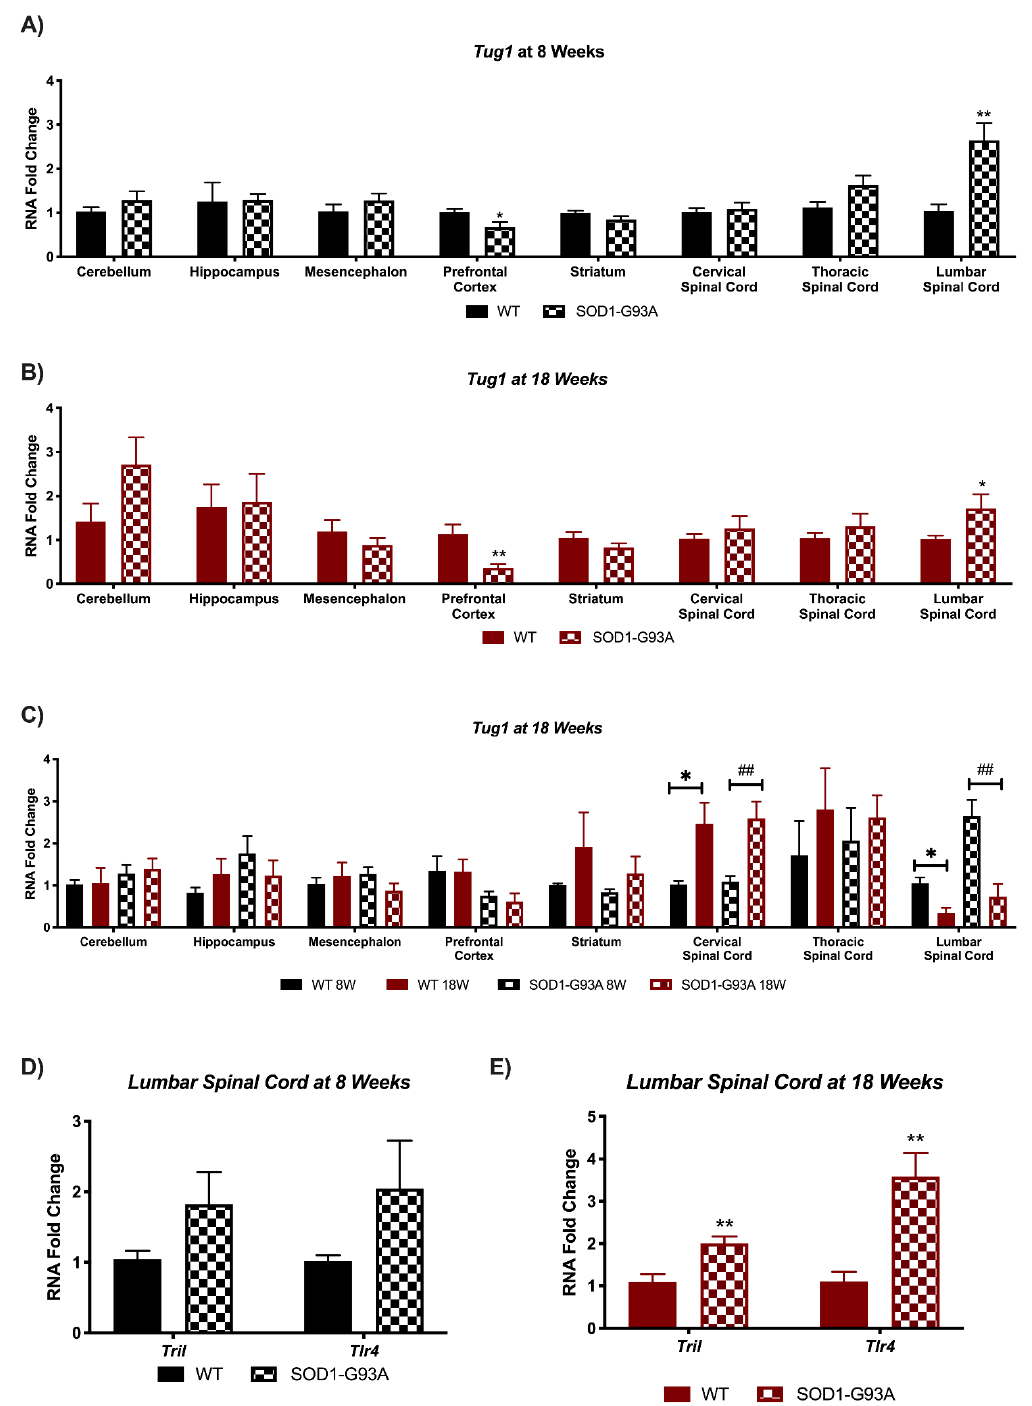
Figure 4. Tug1 expression is deregulated in spinal cord of SOD1-G93A mice with implications for neuroinflammation processes. RNAs expression levels were evaluated by Real Time-PCR in the different conditions. Data are expressed as mean ± SEM. ( A ) Tug1 expression in 8 weeks old WT ( n = 6) mice versus 8 weeks old SOD1-G93A mice ( n = 6). * p < 0.05, ** p < 0.01 vs. WT. ( B ) Tug1 expression in 18 weeks old WT ( n = 6) mice versus 18 weeks old SOD1-G93A mice ( n = 6). * p < 0.05, ** p < 0.01 vs. WT. ( C ) Tug1 expression in 8 weeks old WT mice versus 18 weeks old WT ( n = 6) and 8 weeks old SOD1-G93A mice versus 18 weeks old SOD1-G93A mice ( n = 6). * p < 0.05 vs. WT 8W, ## p < 0.01 vs. SOD1-G93A 8W. ( D ) Tril and Tlr4 expression in 8 weeks old WT ( n = 5) mice versus 8 weeks old SOD1-G93A mice ( n = 5) in lumbar spinal cord. ( E ) Tril and Tlr4 expression in 18 weeks old WT ( n = 6) mice versus 18 weeks old SOD1-G93A mice ( n = 6) lumbar spinal cord. ** p < 0.01 vs.